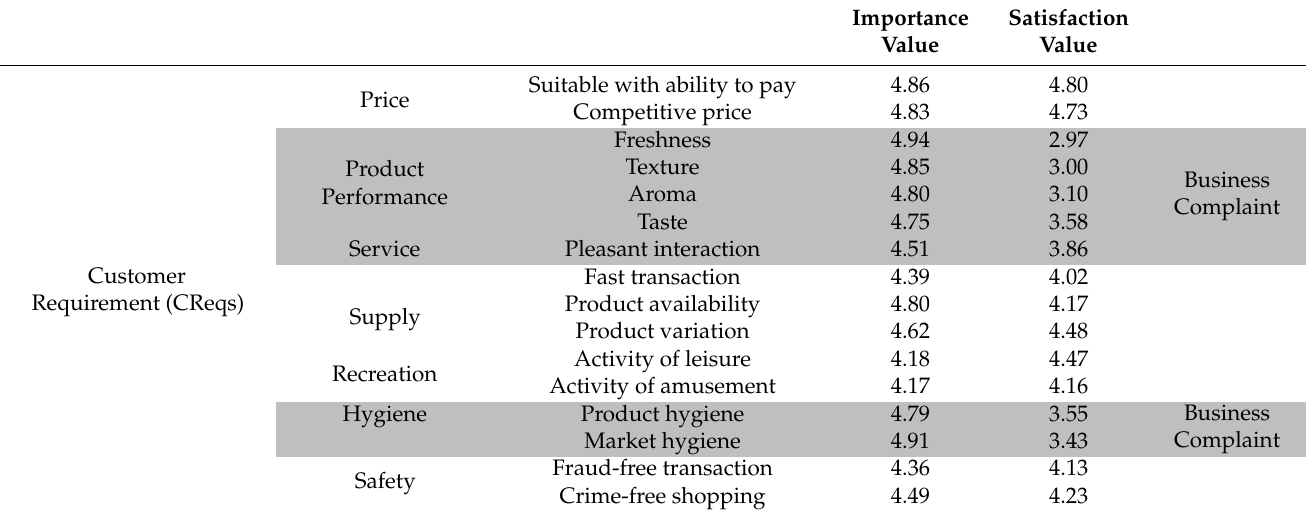
Table 2. Customer requirements (CReqs)